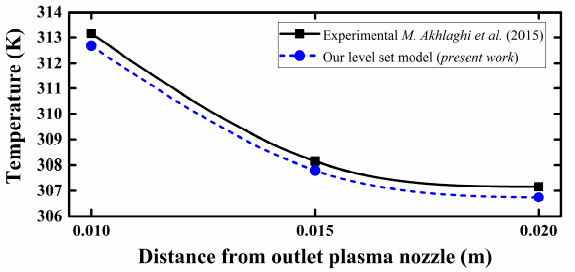
Figure 4. Comparison between temperatures at different distances from the outlet for 6 kV operating voltage obtained experimentally by Akhlaghi et al. [43] and from theoretical predictions.